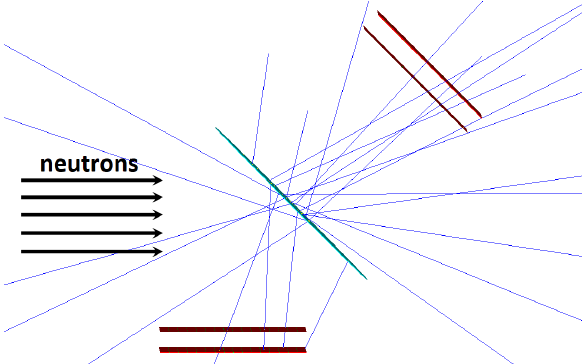
Figure 1. Compilation of the available experimental and eval- uated data on the 12 C(n,p) 12 B reaction cross-section. Huge dis- crepancies can be observed at the peak of the cross-section. Figure 2. Sketch of the setup used in the measurement. The sam- ple was tilted by 45 ◦ with respect to the neutron beam direction in order to increase the reaction yield while two silicon telescopes were placed outside of the beam but close to the sample to ensure a large coverage of the solid